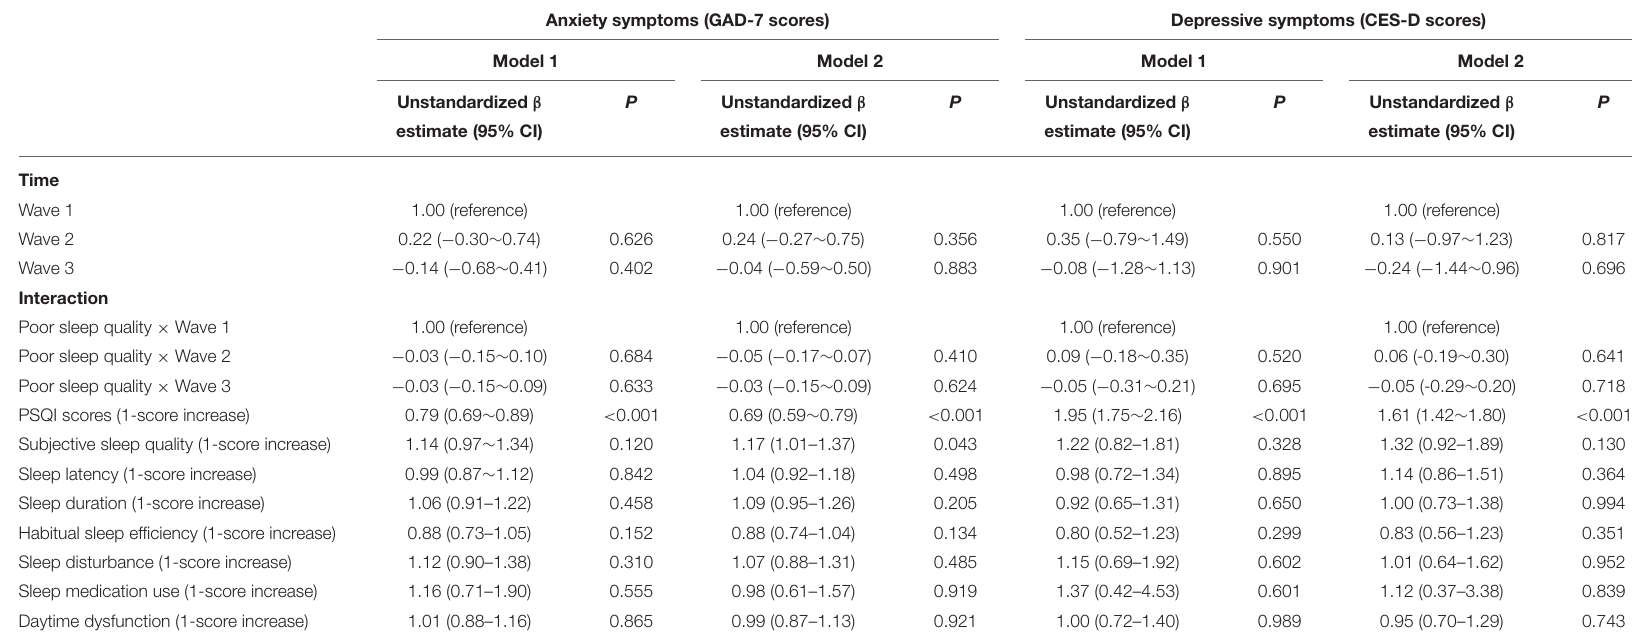
TABLE 3 | Prospective associations of poor sleep quality with anxiety symptoms and depressive